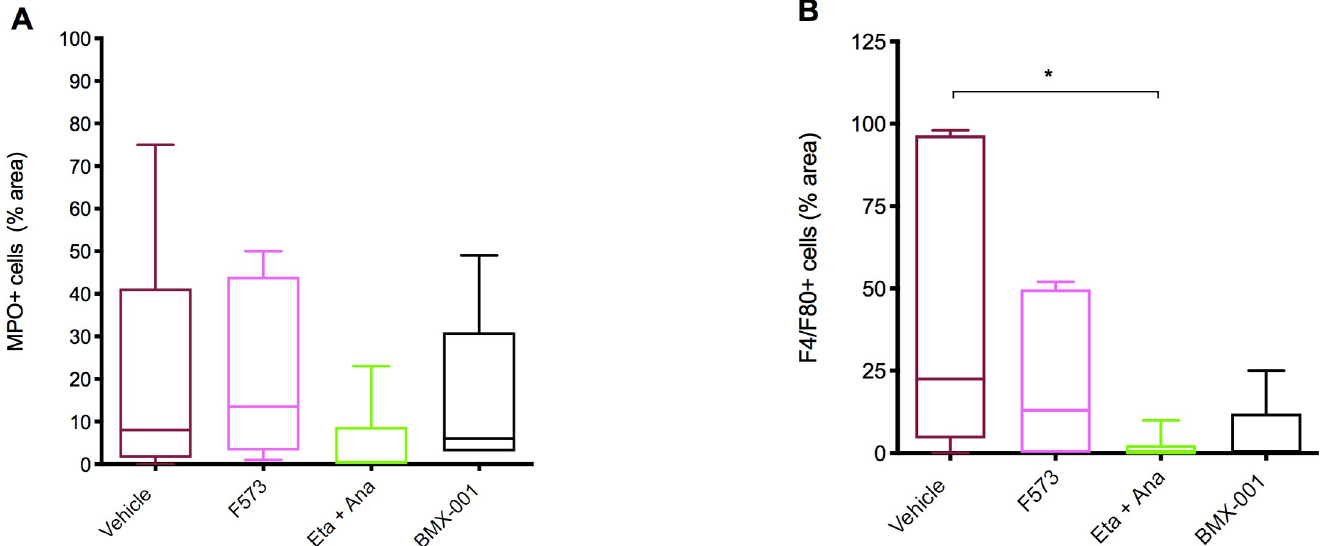
Fig 5. MPO and F4/80 staining. (A) MPO staining calculated as percentage of total area per tissue section (p = 0.15). (B) F4/80 staining calculated as percentage of total area per tissue section (p = 0.047). Data columns show means and SEM, 95% confidence interval (n = 5 per group).